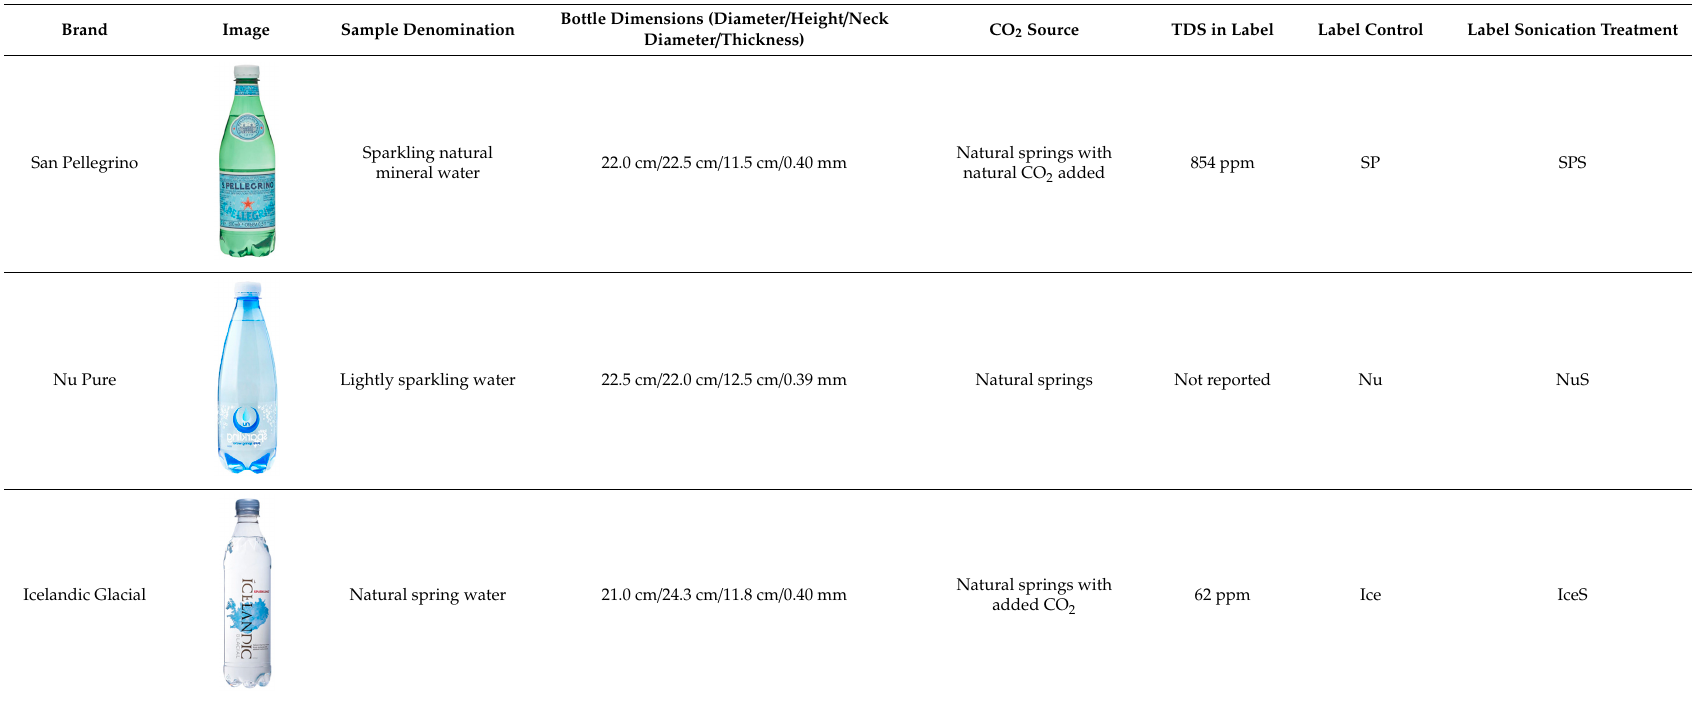
Table 1. Description and labels of samples used for the study.